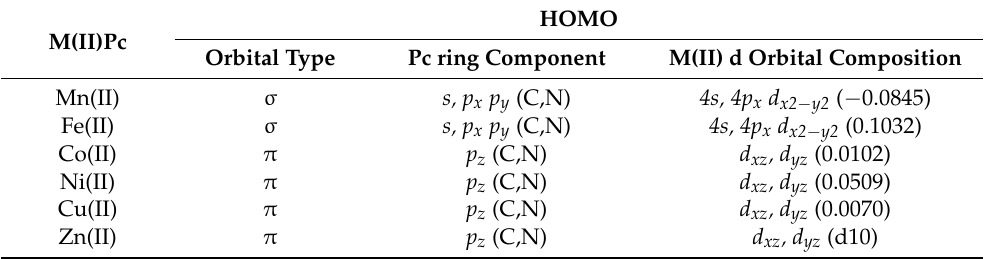
Table 1. HOMO orbital composition in phthalocyanine complex molecule [18,19].